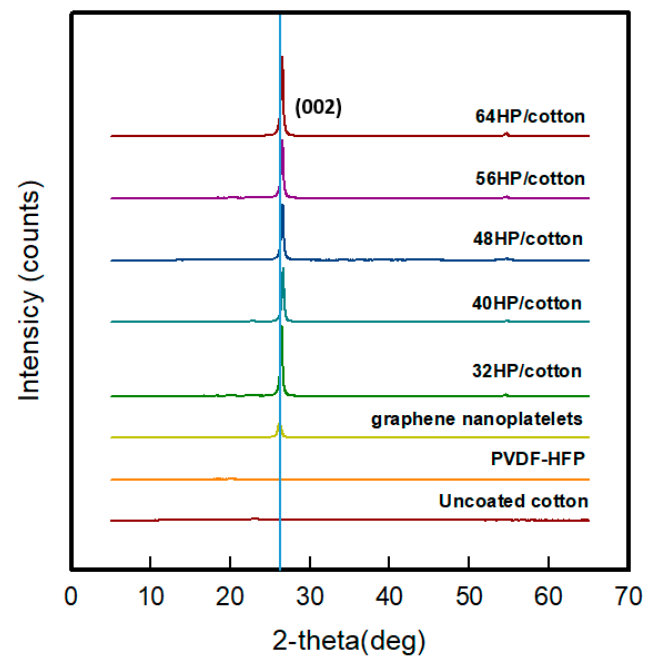
X-ray di ff raction (XRD) pattern of GR / cotton coated with various high-content of Figure 3. X-ray diffraction (XRD) pattern of GR/cotton coated with various high-content of graphene graphene nanoplatelets.